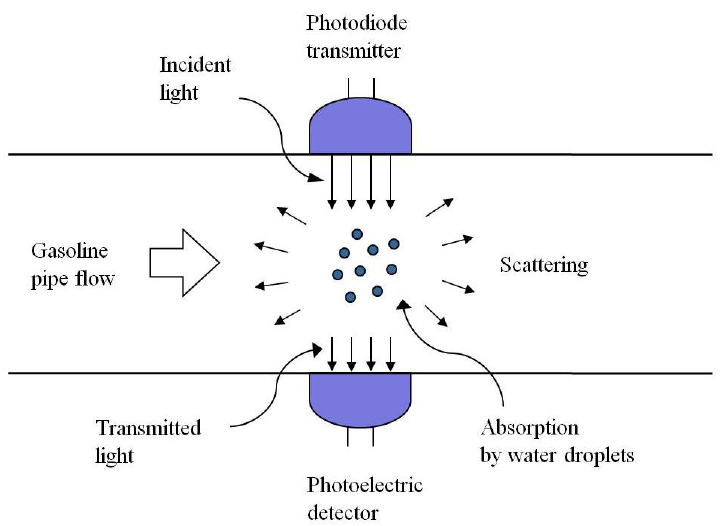
Figure 2. Optical model for spectroscopic water